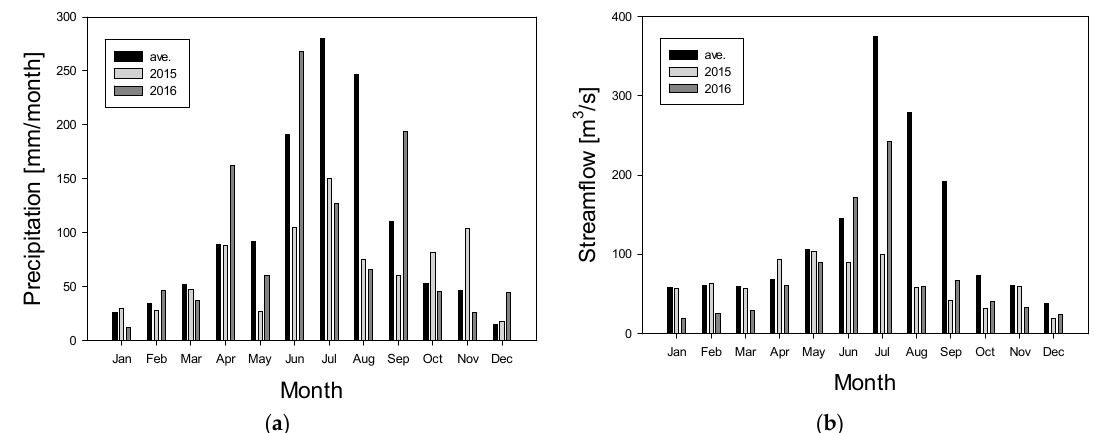
Figure 3. Changes in annual precipitation (Geum River Basin) and monthly streamflow (Gongju).